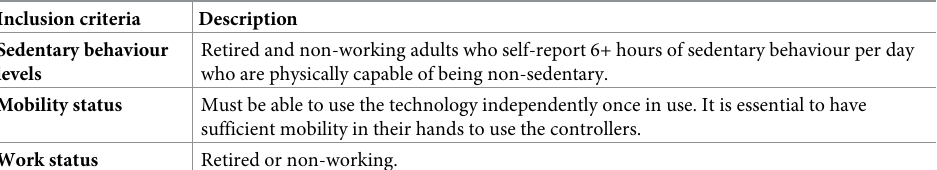
Table 2. Inclusion Criteria.